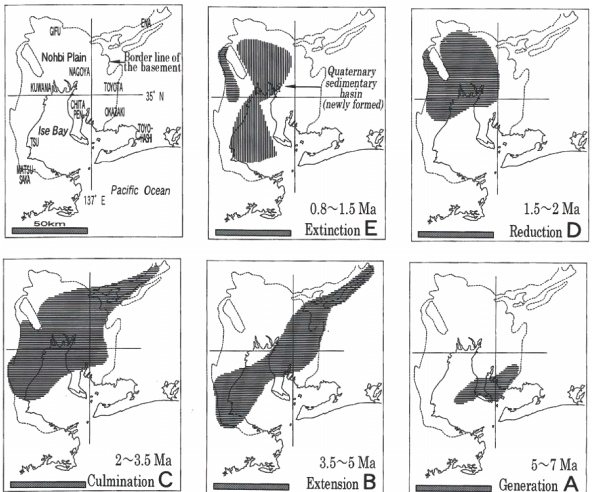
Figure 5. Change in territory (depositional area) of the Lake Tokai sedimentary basin (Makinouchi, 2001). 1Ma: one million years ago.